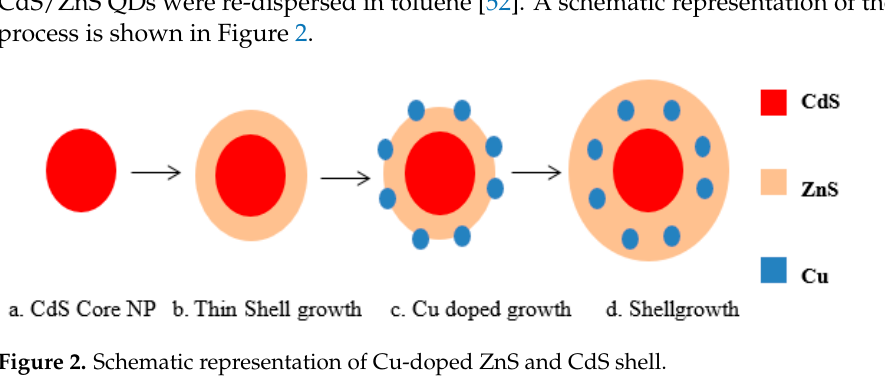
Figure 2. Schematic representation of Cu-doped ZnS and CdS shell.